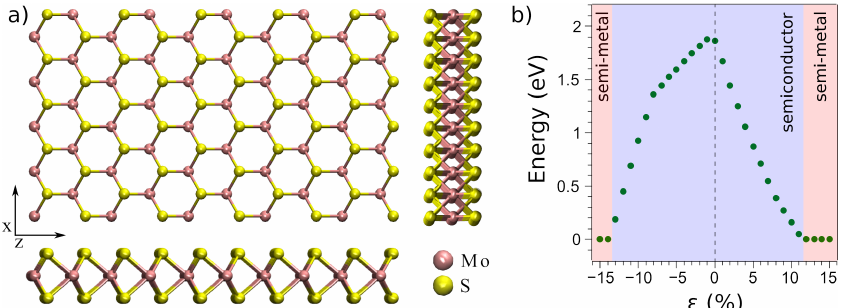
Figure 1. Structure and Energy band-gap for MoS 2 : ( a ) Schematic of top and lateral view of a MoS 2 mono-layer; ( b ) Energy band-gap E g as a function of compression (cid:101) for monolayer MoS 2 . Elongation or compression of MoS 2 provokes a closure of the energy band-gap up to a transition from semiconductor to semi-metal.